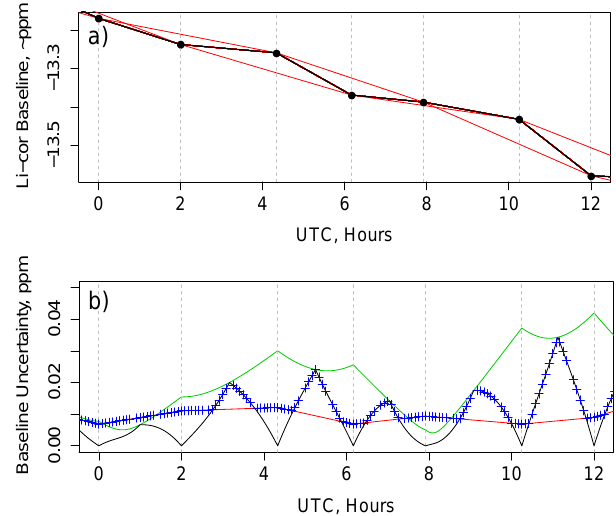
Fig. 4. (a) Measured Li-7000 baseline signal s b (black filled cir- cles), linearly interpolated in time (black lines), and alternate real- izations of the baseline obtained by leaving out individual baseline measurements (red lines). The analyzer signal is the estimated mole fraction difference from the reference gas based on the factory cal- ibration. (b) The analyzer short-term precision u p (red), defined as the time-interpolated 30s standard deviation of the individual base- line measurements; the standard deviation computed across all real- izations of the analyzer baseline σ b (green); and the baseline-drift uncertainty (black), which is the green curve weighted by a function that varies linearly from 0 at times t b to 1 at times halfway between sequential baseline measurements. The total analyzer baseline un- certainty u b at any time is indicated by the blue crosses and is the larger of u p or the time-weighted drift